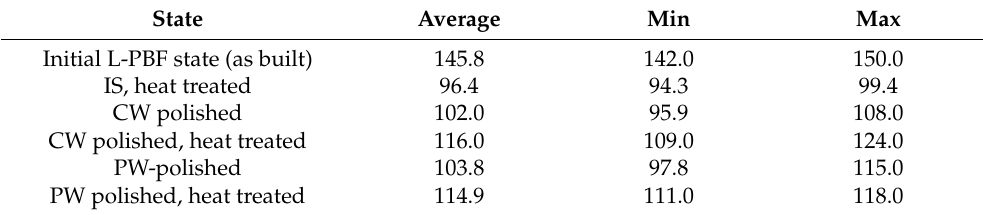
Table 5. Material hardness according to Vickers HV 0.1, measured 0.1 mm below the surface at the initial state and heat-treated state, respectively, at the centre of the polishing zone. State Average Min Max Initial L-PBF state (as built)